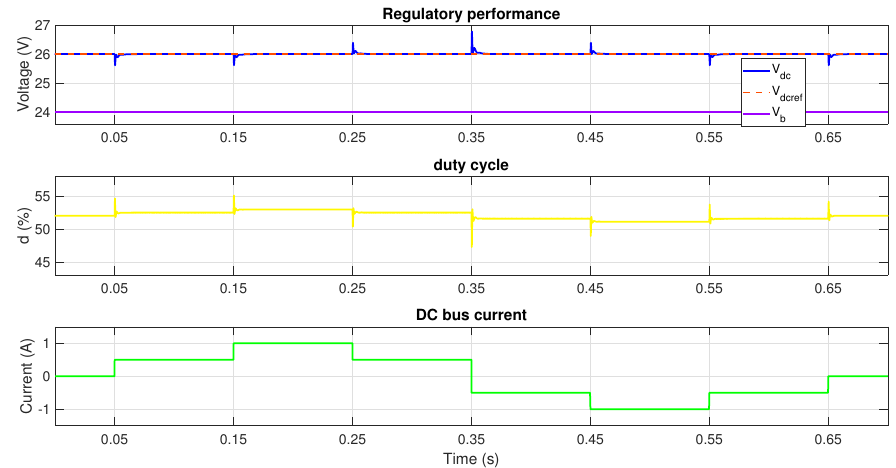
= 26 V (boost mode). ref